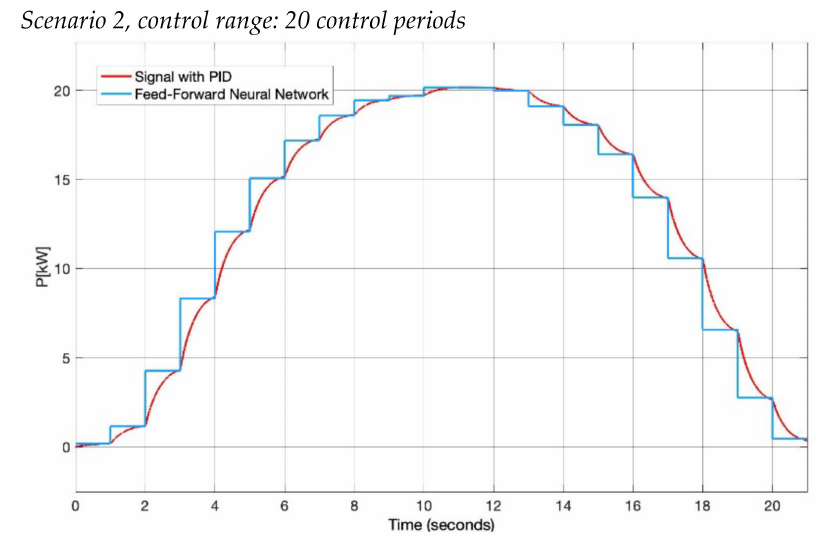
Figure 32. Control signal for BESS 2, p.f. = 0.95,